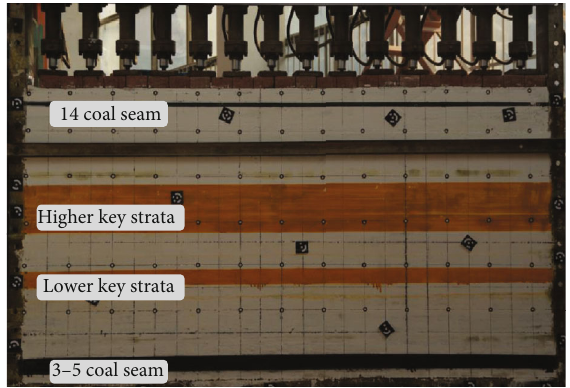
Figure 4: Similar simulation